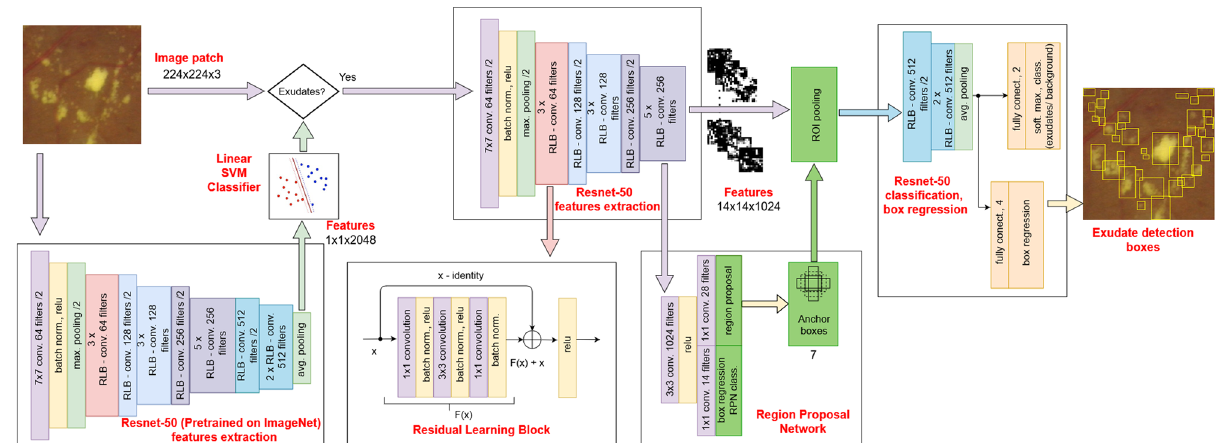
Figure 1. Proposed method for localisation of exudates on retinal images using a Resnet-50 object